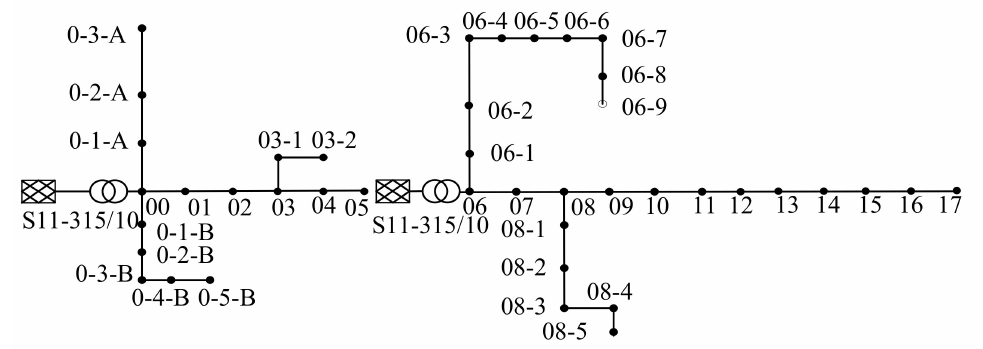
Figure 8. Distribution network topology of capacity